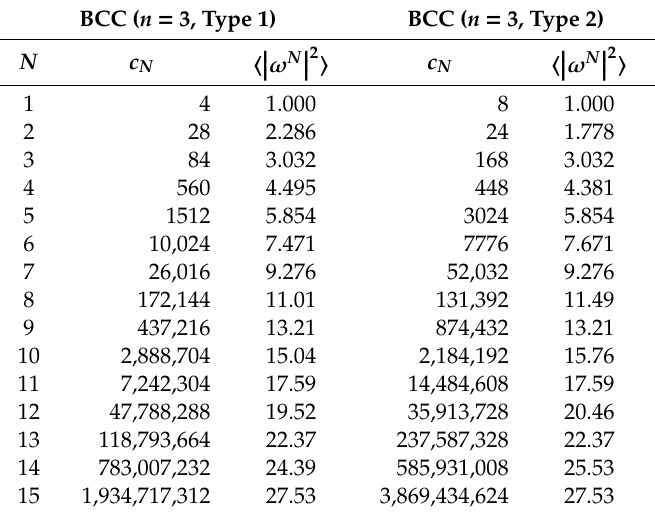
Table A7. Properties of SAWs on BCC lattice with 3 layers between the confining planes ( n = 3, Type 1, 2).